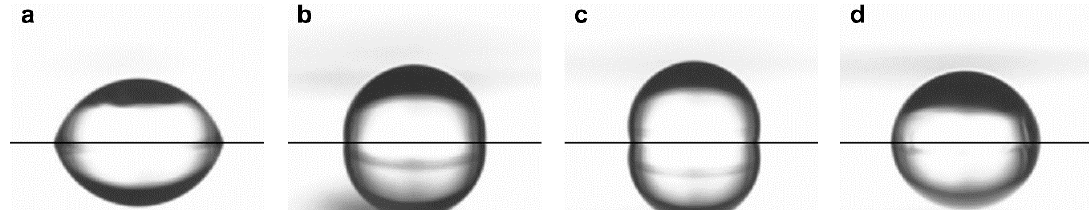
Figure 5. Images of 0.5- μ L drops deposited on the surface of samples untreated ( a ), and Type-A ( b ), Type-B ( c ) and Type-C ( d ) treated. The black line is drawn as a guide to the eye to outline the surface and to separate the drop from its reflection. Table 2. Apparent contact angle (CA) for samples untreated and treated as indicated.